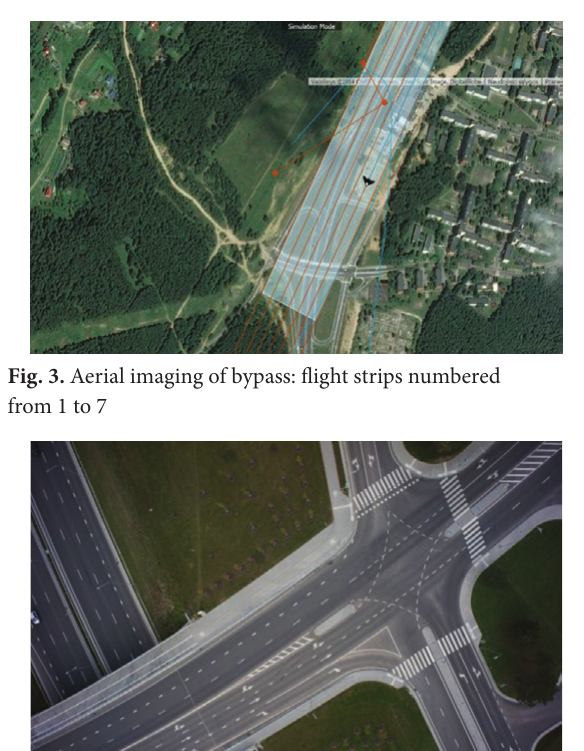
Fig. 2. UAV used as platform for taking images over area